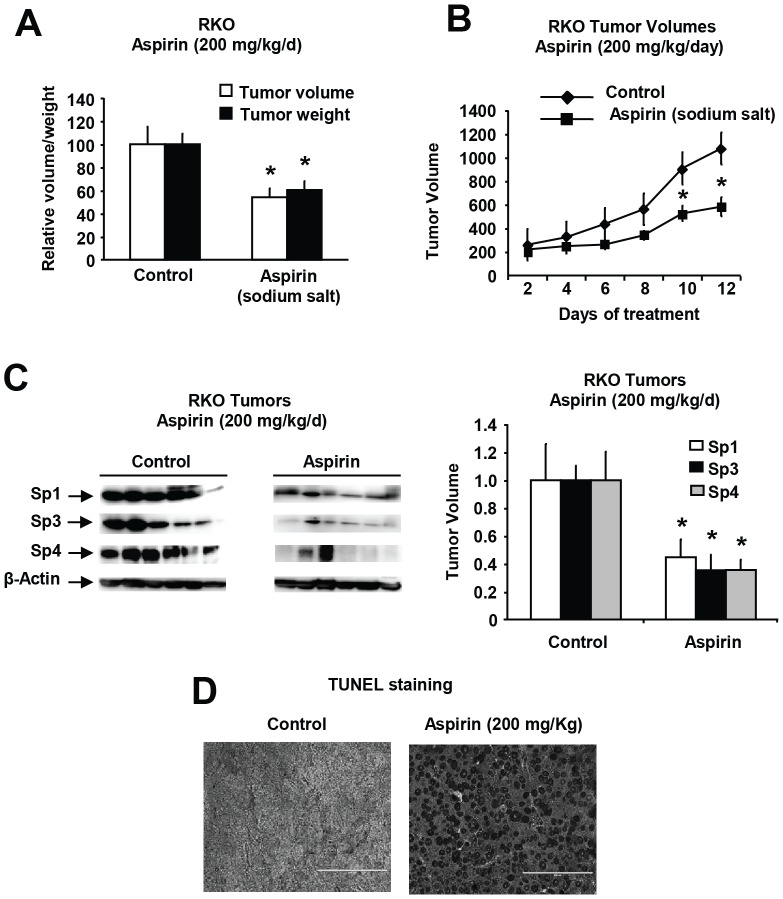
Aspirin inhibits colon tumor growth in athymic nude mice (xenografts).Inhibition of tumor weight (A) and volume (growth) (B) in athymic nude mice administered the sodium salt of aspirin. Athymic nude mice bearing RKO cells as xenografts were treated with the sodium salt of aspirin, and tumor volumes and weights were determined after sacrifice as described in the Experimental Procedures. (C) Expression of Sp1, Sp3 and Sp4 in colon tumors. Tumor lysates from solvent (control) and aspirin-treated mice were analyzed by western blot analysis as described in the Experimental Procedures. Expression of Sp1, Sp3 and Sp4 in aspirin-treated tumors compared to solvent (control)-treated tumors (set at 100%) was determined by densitometry, and β-actin was used to normalize protein expression. Results are means ± SE (6 replicates) and significant (p<0.05) inhibition of Sp1, Sp3 and Sp4 protein levels by aspirin is indicated (*). (D) Induction of apoptosis. Fixed tumor tissue from control and aspirin-treated mice were analyzed for TUNEL staining as outlined in the Experimental Procedures.